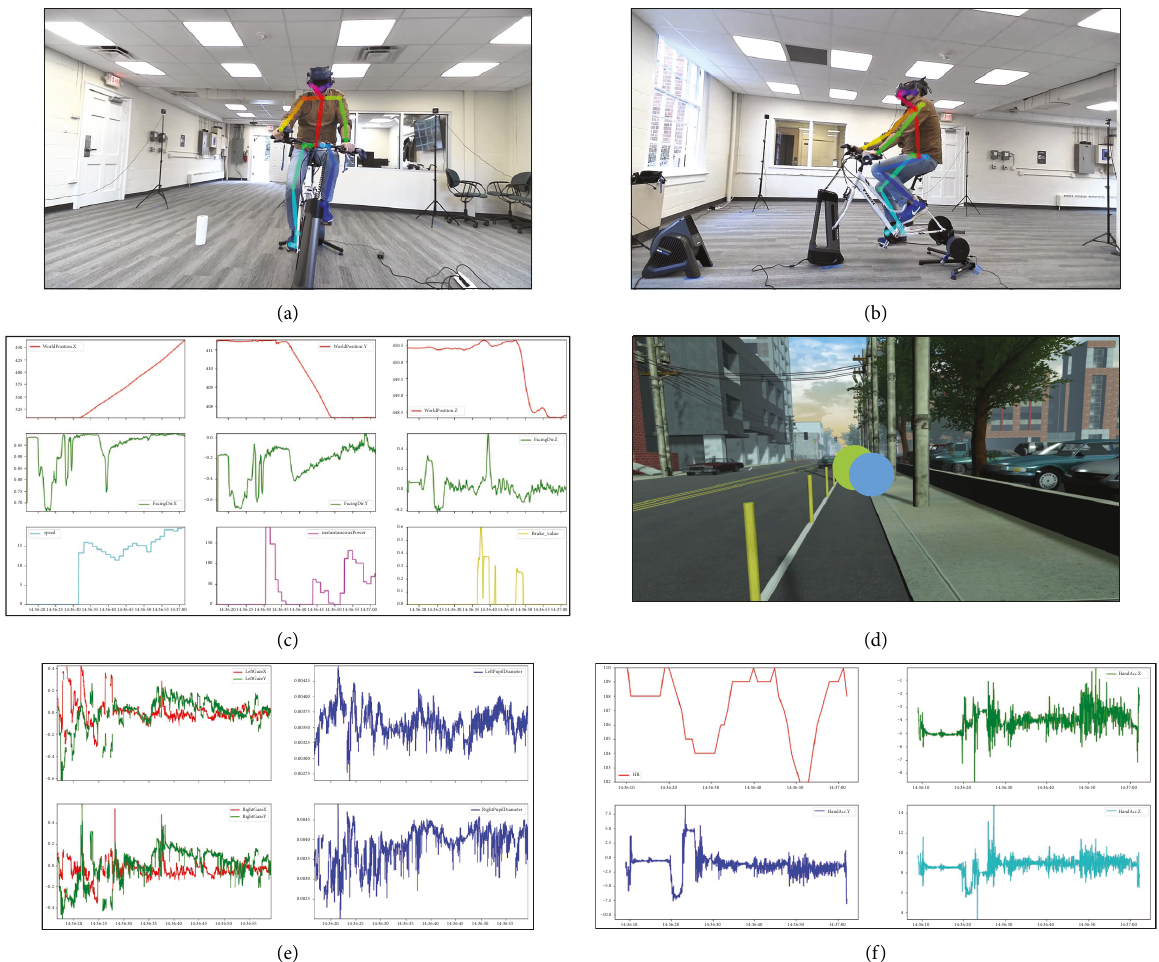
Figure 4: Example of data visualization output. (a, b) Video data from two cameras with body position detection; (c) position and controllers input data in VR; (d) field of view VR video recording with gaze mapping, and green/blue dots indicate left/right eye fixation; (e) eye tracking data, includes gaze direction and pupil diameter; (f) heart rate and hand acceleration data from the smart